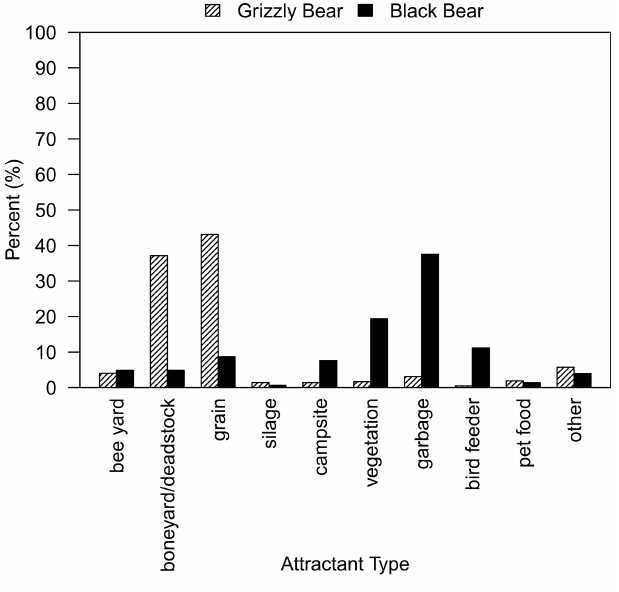
Fig. 6 . Spatial locations of grizzly bear ( Ursus arctos ) occurrences records in southwestern Alberta, Canada 1999 through 2014 grouped in four-year increments. The shaded green area represents the public land portion of the study